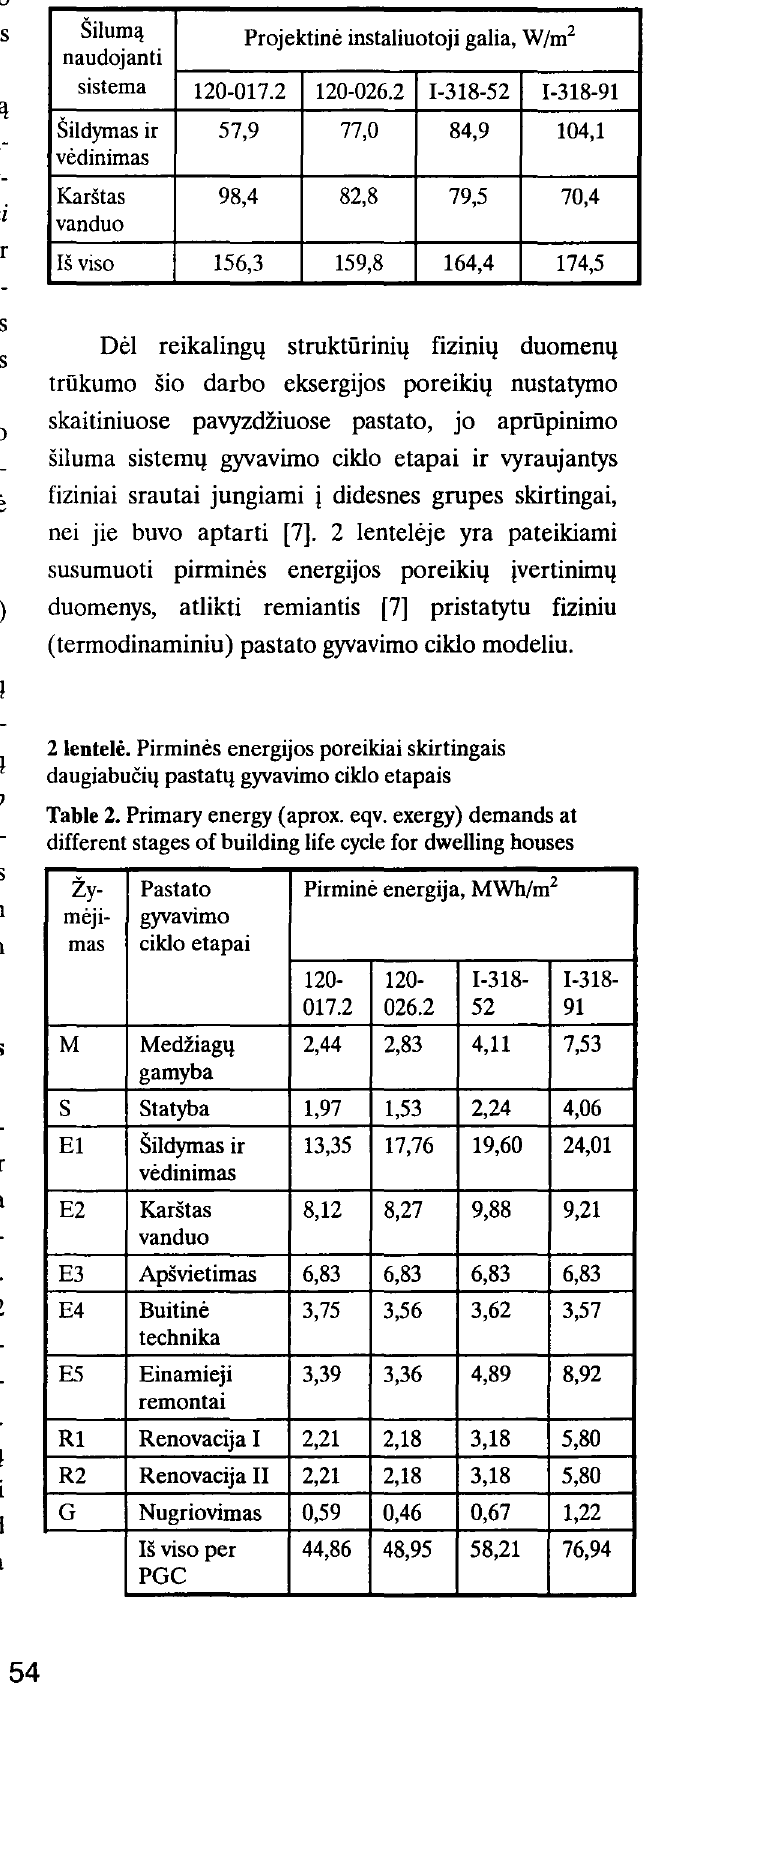
Table 1. Installed specific heat capacity of heating and hot water needs for multi-storey dwelling houses